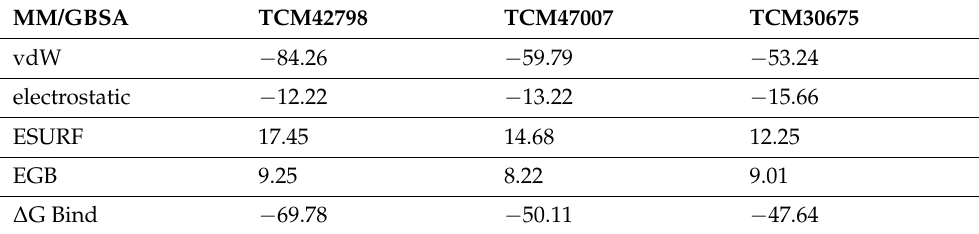
Table 2. Binding free energy calculated as MM/GBSA. All the values are given in kcal/mol. MM/GBSA